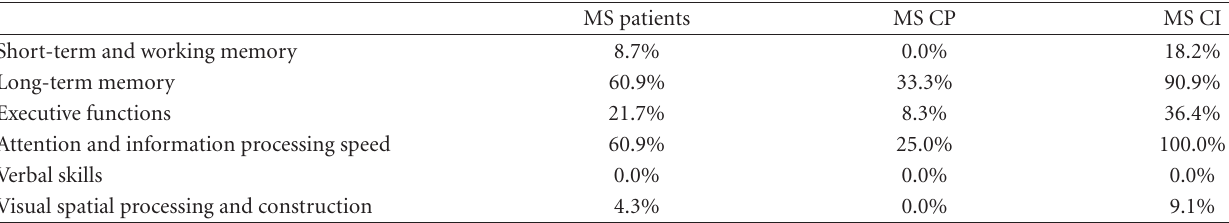
Table 3: Frequency of subjects with abnormal tests in the main cognitive domains in the MS patient subgroups.